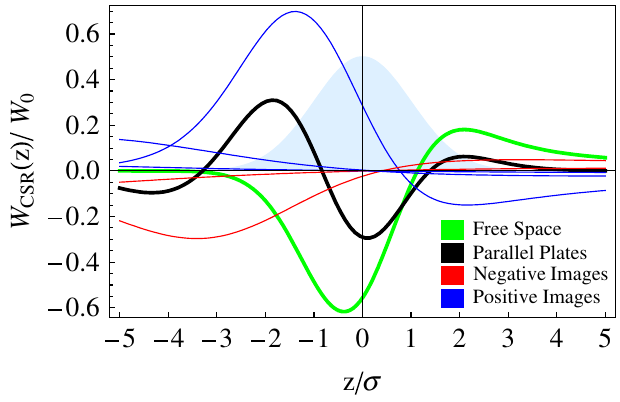
FIG. 7. (Color) The free space and shielded CSR wakes in a bend. The contributions to the shielded wake of individual image bunches are shown in red and blue. A 1 GeV Gaussian bunch with (cid:10) ¼ 0 : 3 mm is used in a bend of radius (cid:7) (cid:1) 1 ¼ 10 : 0 m . The shielding height H ¼ 2 cm